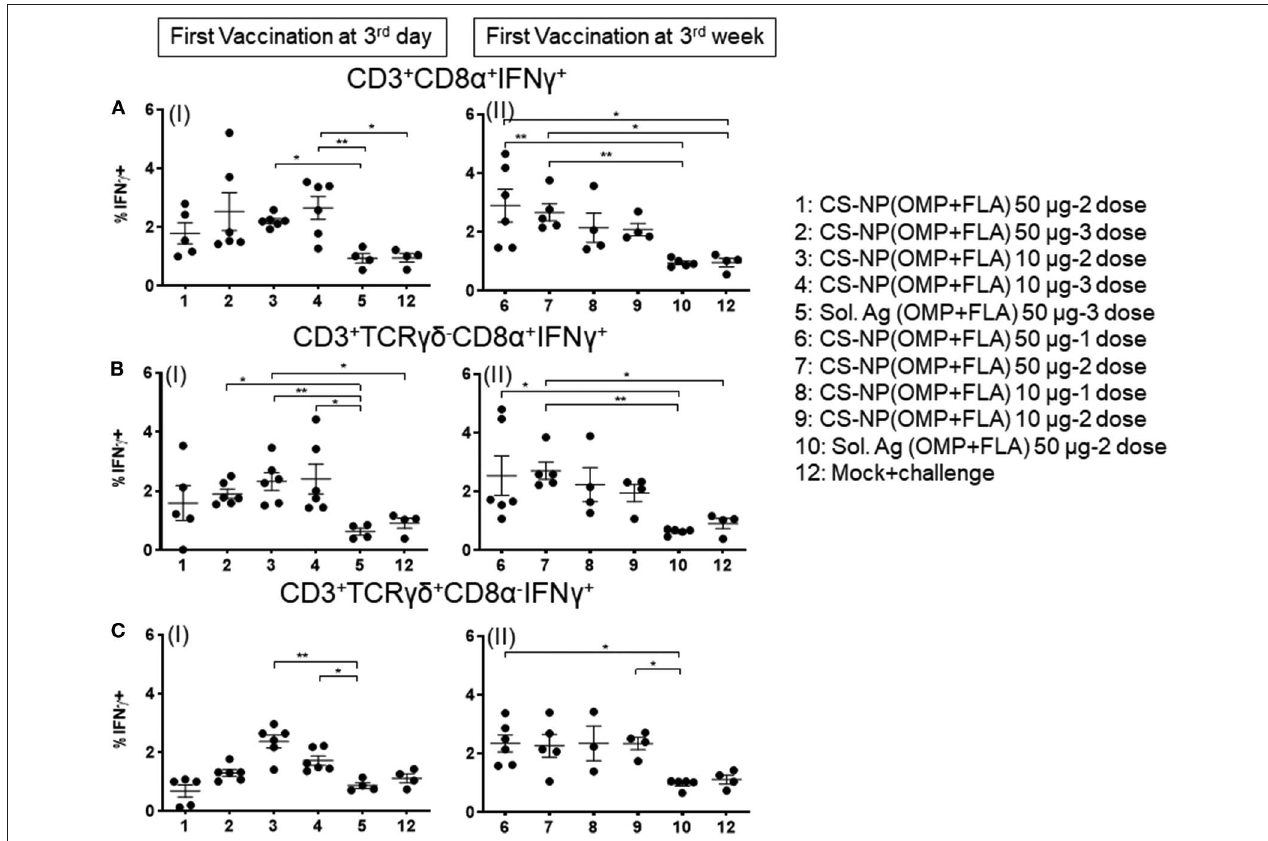
FIGURE 6 | Salmonella antigen specific proliferated T lymphocyte subsets in the splenocyte of vaccinated and SE challenge birds. Splenocytes isolated on the day of necropsy were restimulated with vaccine antigens (OMP + FLA). The frequency of activated IFN γ + secreting lymphocytes were determined by flow cytometry. Average frequency of lymphocytes: (A) CD3 + CD8 α + IFN γ + (I and II); (B) CD3 + TCR γδ − CD8 α + IFN γ + (I and II); and (C) CD3 + TCR γδ + CD8 α − IFN γ + (I and II) from all the experimental groups were quantified. Data were presented as average percentage of indicated lymphocyte subset ± SEM. Significant differences were calculated between vaccinated and Sol. Ag (OMP + FLA) or mock challenge group by Kruskal–Wallis test followed by Dunn’s multiple comparison test. * P < 0.05, ** P <